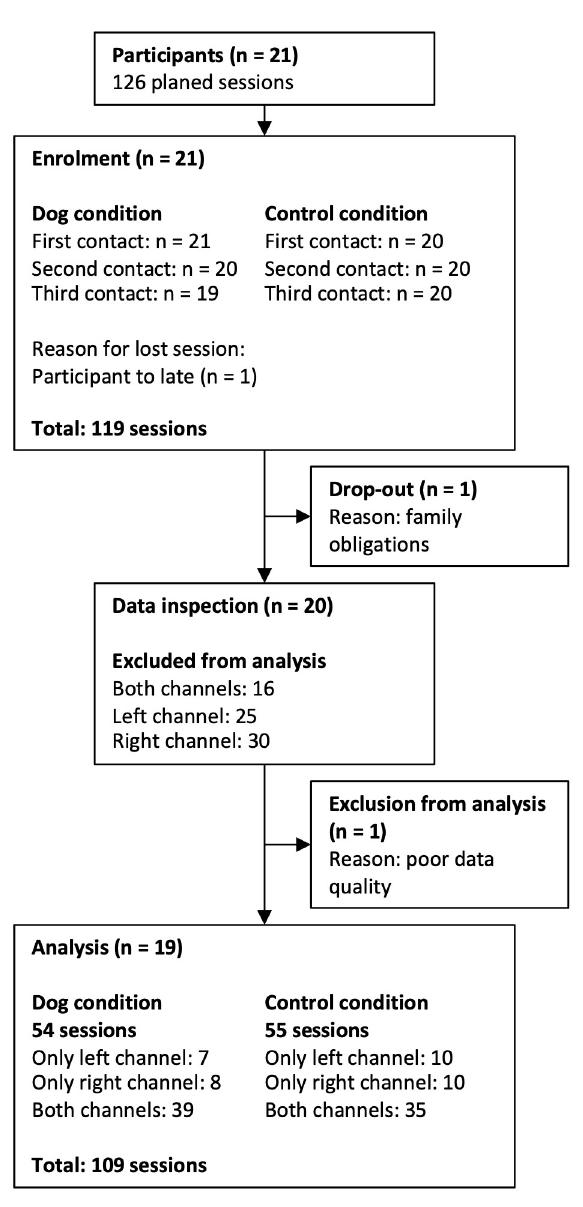
Fig 2. Flow diagram of the study. HHb tended to be lower in the presence of the dog compared to in the presence of the plush animal (estimate = - 0.35 μ mol/l, CI = − 0.71–0.02, p = 0.064). The difference was highest in phase neutral 2 (Fig 3B). This result was not influenced by the visibility of the dog owner. 3.2.2 Total hemoglobin. When stimulation increased, total hemoglobin (tHb) in the pre- frontal lobe increased significantly from phase neutral 1 to the petting phase by 1.54 μ mol/l (CI = 1.08–2.01, p < .001). After removal of the stimulation in phase neutral 2, tHb stayed con- stant and was still significantly higher compared to phase neutral 1 (estimate = 1.70 μ mol/l, CI = 1.24–2.17, p < .001).